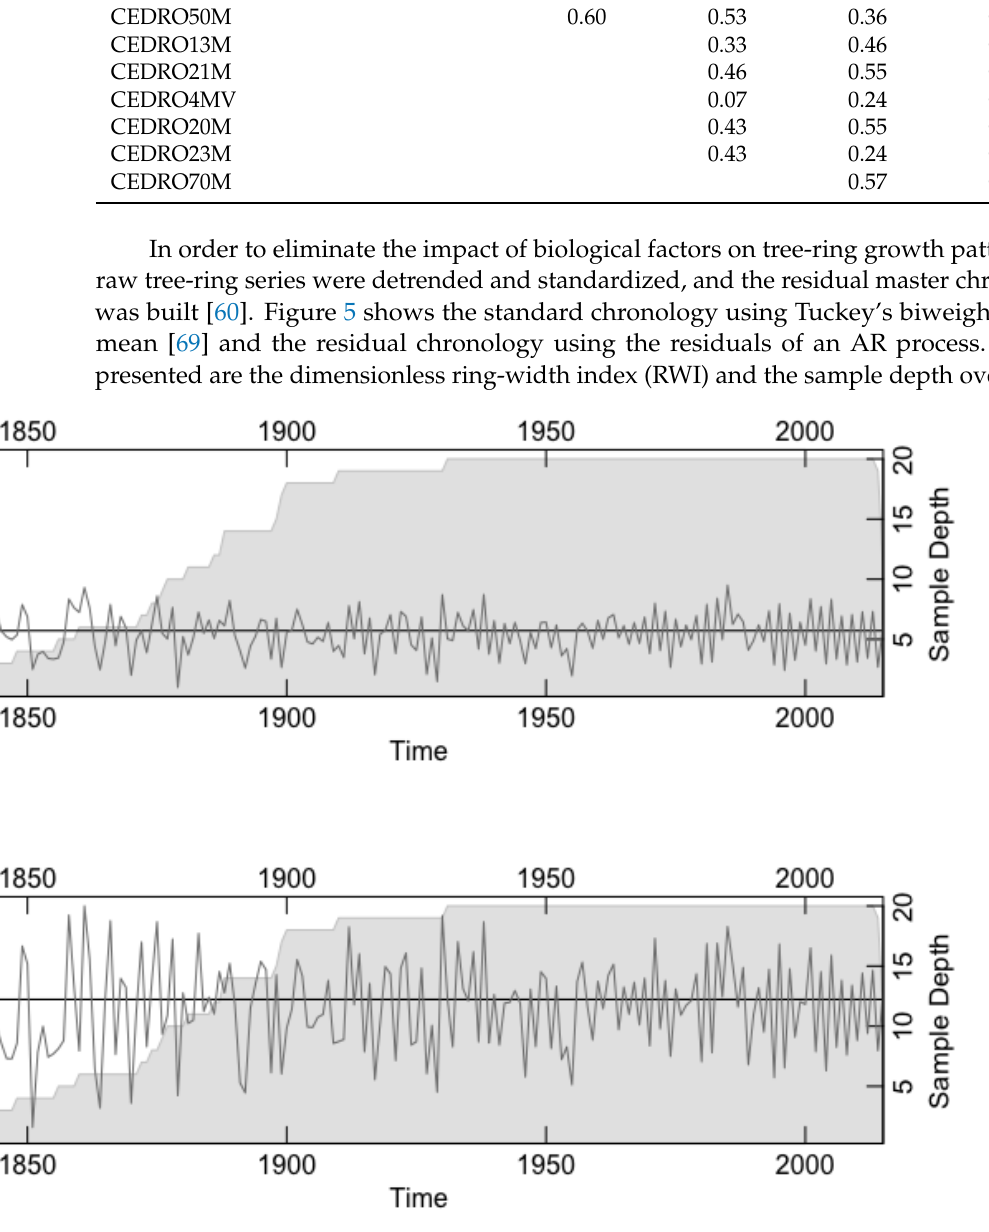
Figure 5. Standard chronology (above) and residual chronology (below).